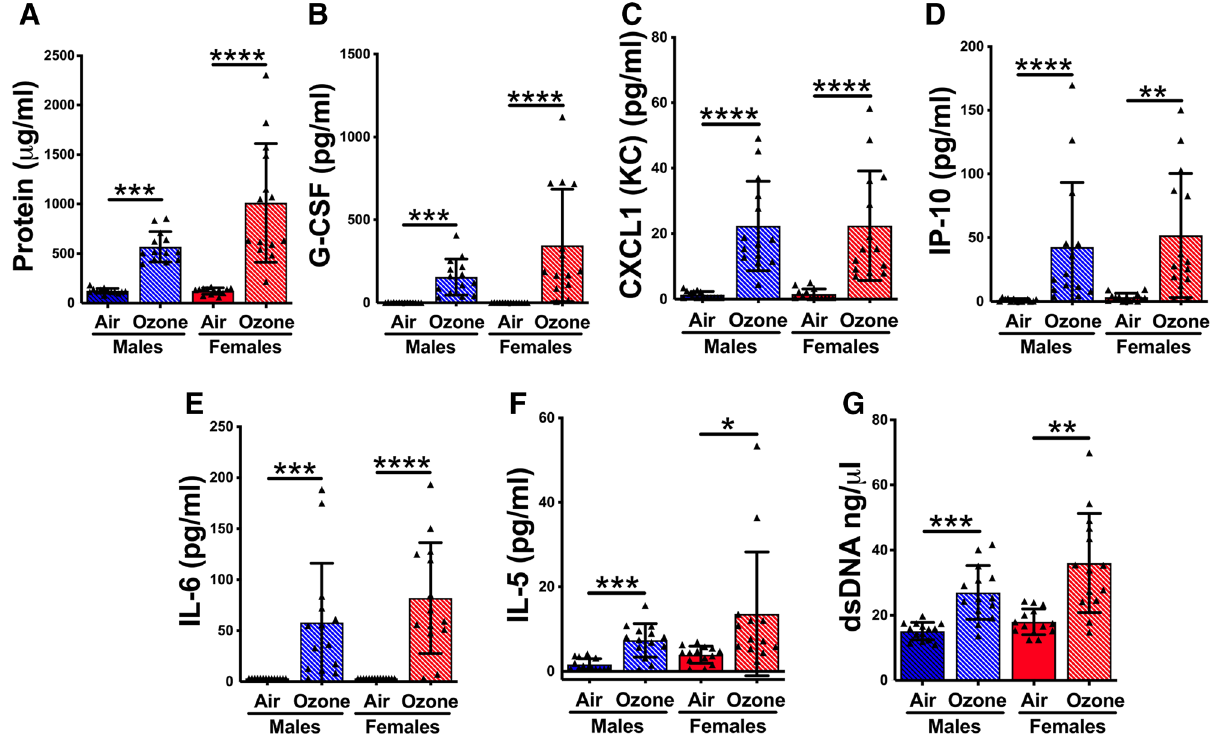
Figure 1. Ozone exposure causes exaggerated lung injury and inflammatory mediators in ozone-exposed mice. ( A ) Protein concentration (µg/ml) in the cell-free BALF from the air- and ozone-exposed males and females. Significant main effect was detected (Kruskal Wallis Statistic = 40.34; df = 3; p < 0.0001). Concentration (pg/ml) of G-CSF ( B ), CXCL1 (KC) ( C ), IP-10 ( D ), IL-6 ( E ), and IL-5 ( F ), in the cell-free BALF from air- and ozone-exposed males and females. The G-CSF and IL-6 concentrations for air-exposed groups in Panels B and E, respectively, were below detection limit. The values for such samples were obtained by subtracting 0.01 from lowest detection limit. Significant main effect was detected for G-CSF, KC, IP-10, IL-6, and IL-5 (Kruskal Wallis Statistic = 35.67 for IL-6, 41.72 for G-CSF, 27.64 for IL-5, 35.97 for IP-10, and 41.15 for KC; df = 3 for all; p < 0.0001 for all). ( G ) Double-stranded DNA (dsDNA) concentration (ng/ml) in the cell-free BALF from the air- and ozone-exposed males and females. Significant main effect was detected (Kruskal Wallis Statistic = 29.89; df = 3; p < 0.0001). Error bars represent Standard Deviation (SD). * p < 0.05, ** p < 0.01, *** p < 0.001, **** p < 0.0001 using Kruskal Wallis test followed by Dunn’s post hoc comparisons. (n = 13–14 per group). BALF, bronchoalveolar lavage fluid; G-CSF, Granulocyte colony-stimulating factor; CXCL1, Chemokine (C-X-C motif) ligand 1; KC, Keratinocytes-derived chemokine; IP-10, Interferon-gamma induced protein 10; IL-6, Interleukin 6; IL-5, Interleukin